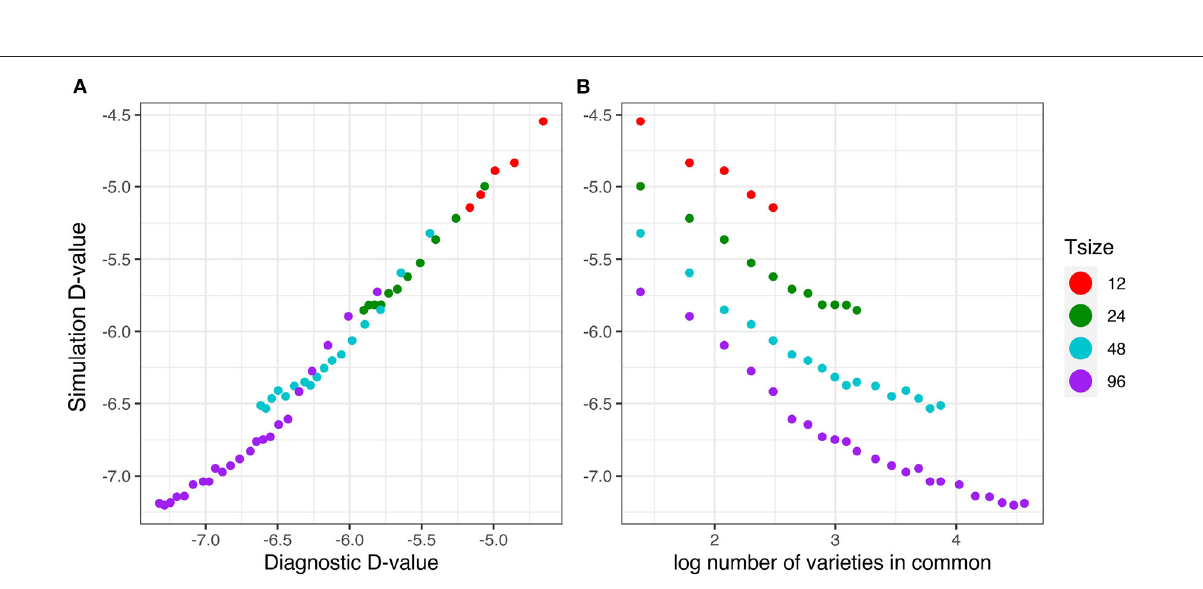
Frontiers in Plant Science |